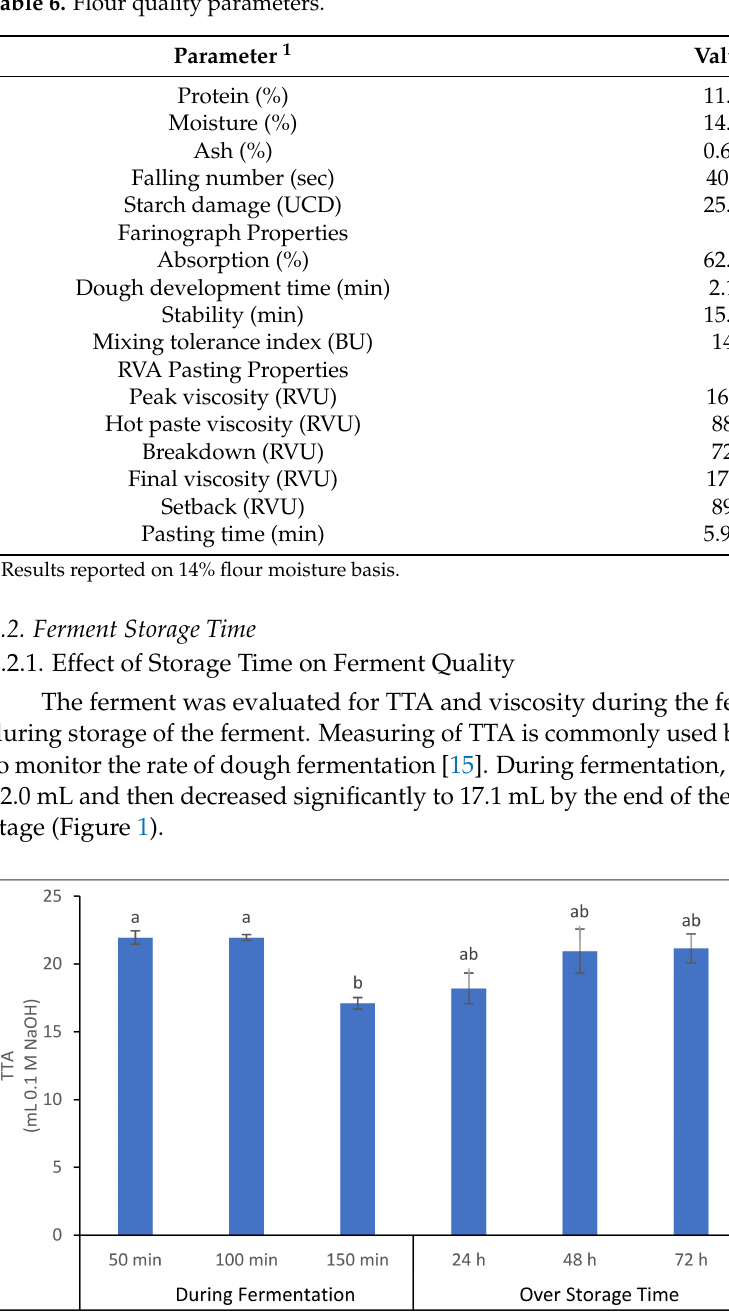
Figure 1. Changes in total titratable acidity of the ferment during fermentation and over storage time. Bars represent the means and standard deviations of two replication. Bars with different letters indicate significant differences for the results at p < 0.05 (Tukey–Kramer